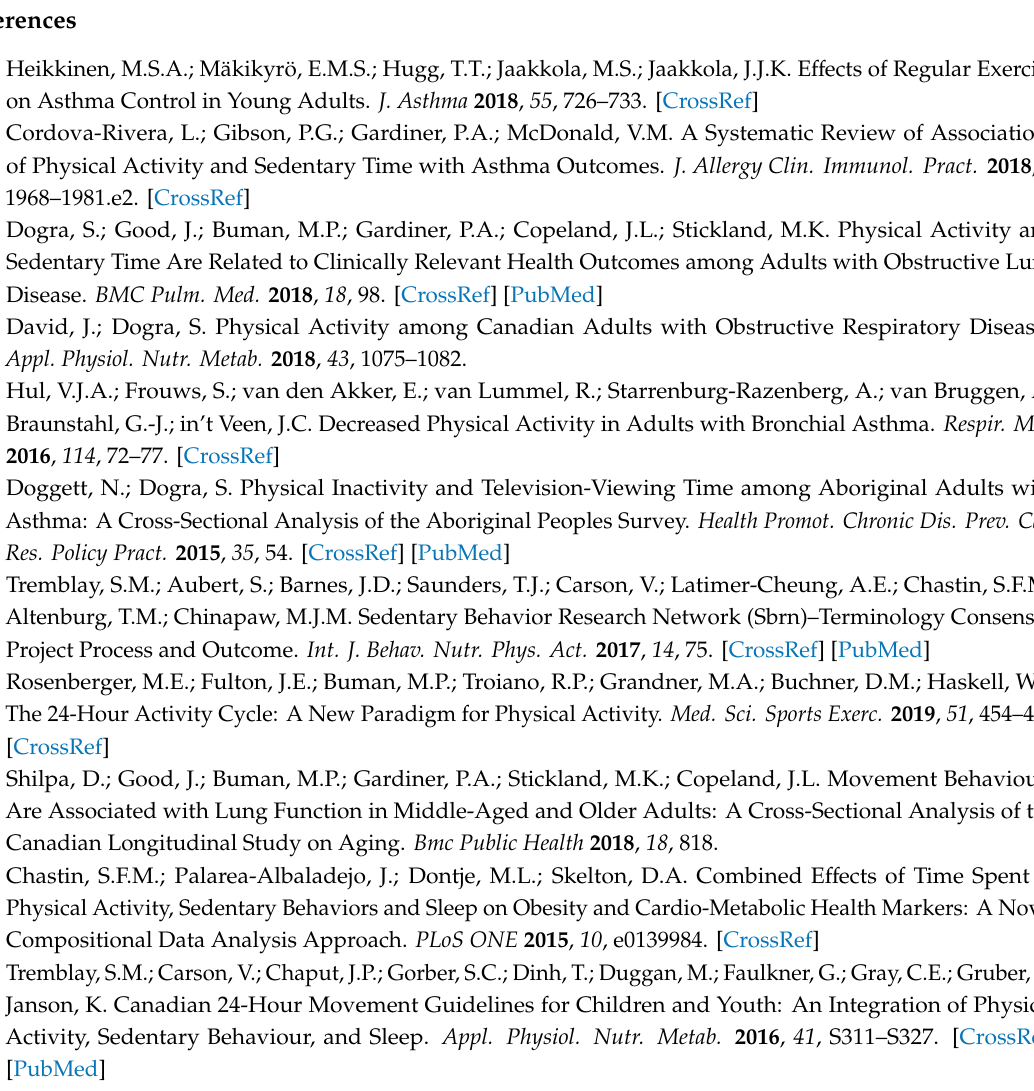
Table S1: Recommendations and Strategies pertaining to Physical Activity from Clinical Practice Guidelines for Asthma, Table S2: Recommendations and Strategies pertaining to Sleep from Clinical Practice Guidelines for